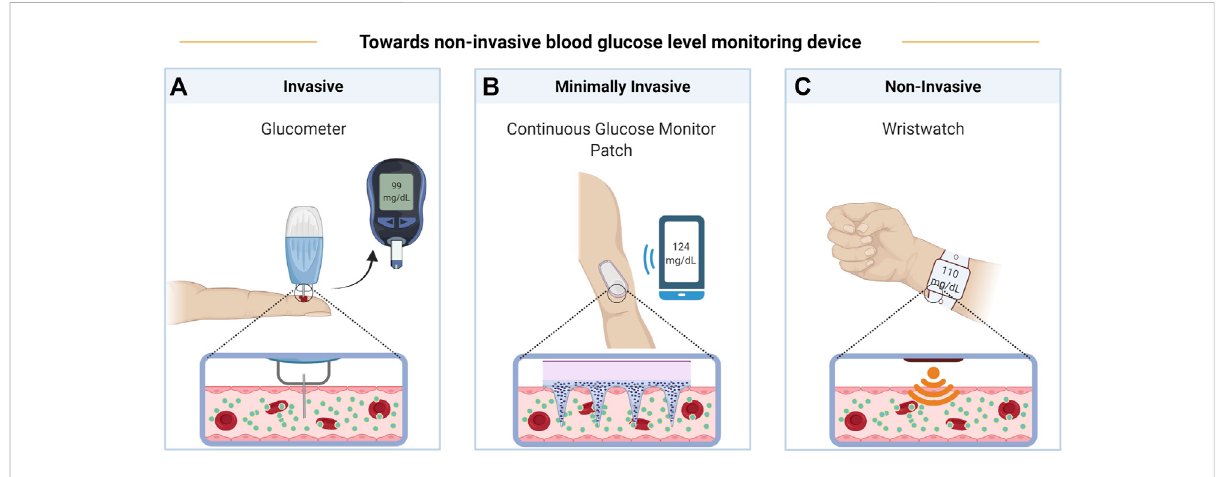
FIGURE 1 EvolutionofBGLmonitoringdevicesfrominvasiveglucometer (A) ,tominimallyinvasivecontinuousglucosemonitoringpatch (B) ,and fi nallyto non-invasive wristwatch (C) . Created with